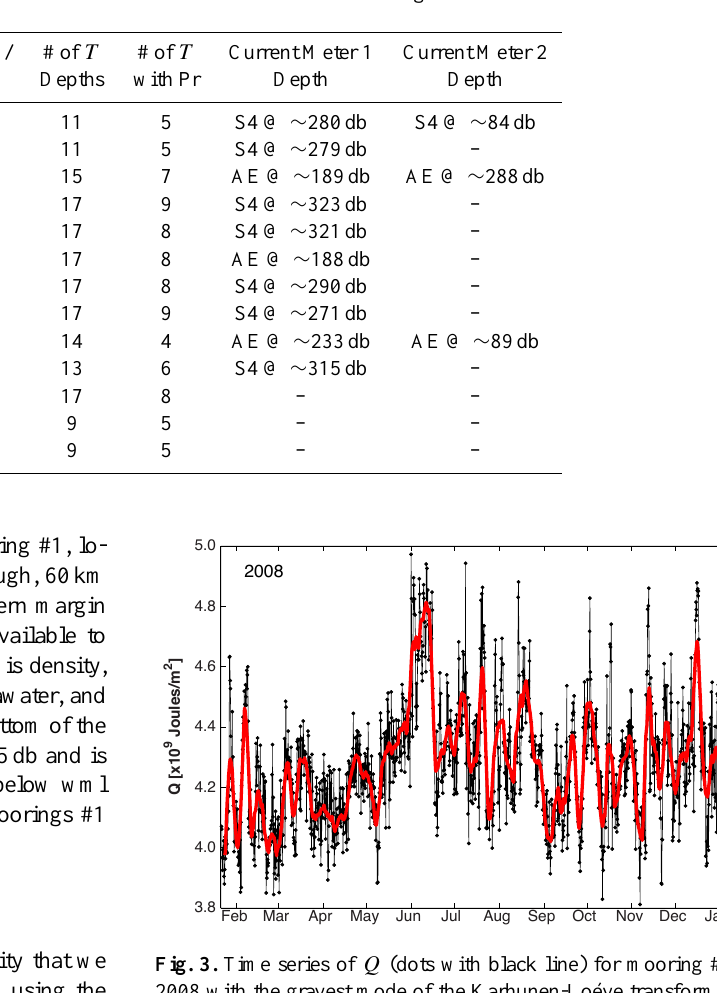
same path due to bathymetric